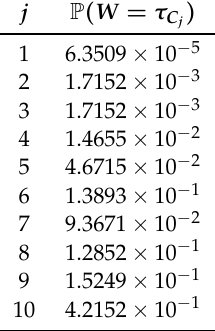
Figure 1. Plots of the joint probabilities P ( W ≥ n , W = τ C Table 4. The stopping probabilities P ( W = τ C